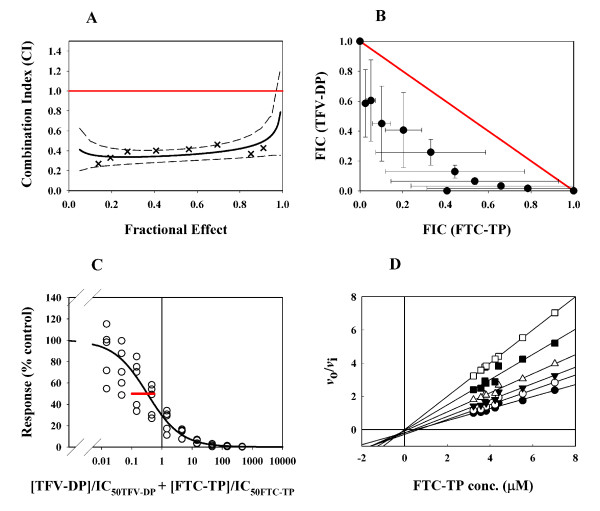
Synergistic inhibition of HIV-1 RT by TFV-DP+FTC-TP combination analyzed by different methods. (A) The median-effect analysis where the solid line presents curve fitting of the CI values as a function of the fractional effect. The red line at CI = 1 represents additivity. The dashed lines represent 95% confidence interval. TFV-DP and FTC-TP are combined at 1:1 IC50 ratios (1:10 molar ratios) with an average CI value of 0.47; (B) The isobologram analysis where the diagonally drawn solid line (in red) represents additivity. Average deviation from dose-wise additivity was -0.43 (p = 0.001), indicating a synergistic effect of the combination; (C) The Berenbaum combination indices analysis where the open circles are data from five experiments and the solid line represents the CI line. The red bar at the CI50 indicates the 95% confidence intervals. The bar is to the left of the CI50 = 1 line, indicating synergy for this combination. In this experiment, TFV-DP and FTC-TP were combined at 1:4 IC50 ratios (1:40 molar ratios); (D) The Yonetani-Theorell plot where FTC-TP was tested as the "first drug" and TFV-DP was added as the "second drug" at the following concentrations: (black circle) 0 μM, (open circle) 0.1 μM, (black triangle) 0.2 μM, (open triangle) 0.4 μM, (black square) 0.8 μM, and (open square) 1.6 μM. The Yonetani-Theorell plot shows the lines are converging at the left of the y-axis and the slopes of the lines increased with TFV-DP concentration, indicating the combination was synergistic.